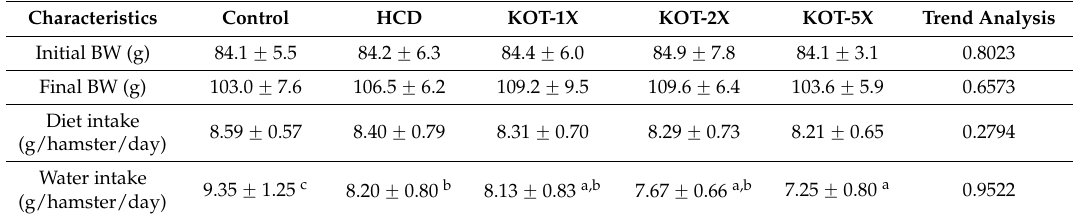
Figure 2. Change in body weight (BW) during the experiment. Golden Syrian hamsters were separated into controls and fed a standard laboratory diet ( n = 8) or experimental diet ( n = 32) and treated as in Figure 1. The BW of hamsters was measured once a week in each group. Data are mean ± SD (standard deviation) for n = 8 hamster per group. HCD (high ‐ cholesterol diet), HCD and the same volume of solution equivalent to BW; KOT ‐ 1X, HCD and 2787 mg/kg/day KOT; KOT ‐ 2X, HCD and 5573 mg/kg/day KOT; KOT ‐ 5X, HCD and 13,934 mg/kg/day KOT. KOT: tomato juice from Kagome Ltd. Table 2. Body weight (BW) and daily food intake for the experimental groups.